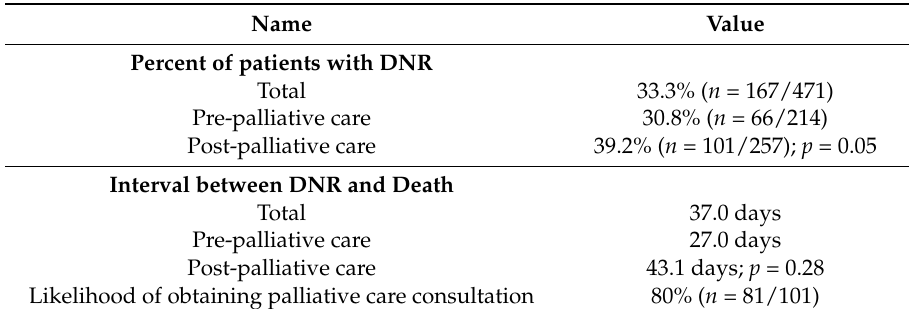
Table 2. Palliative care